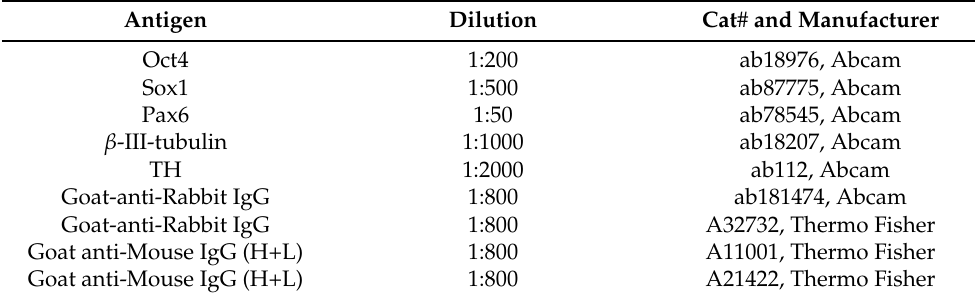
Table 5. Antibodies used in the study for